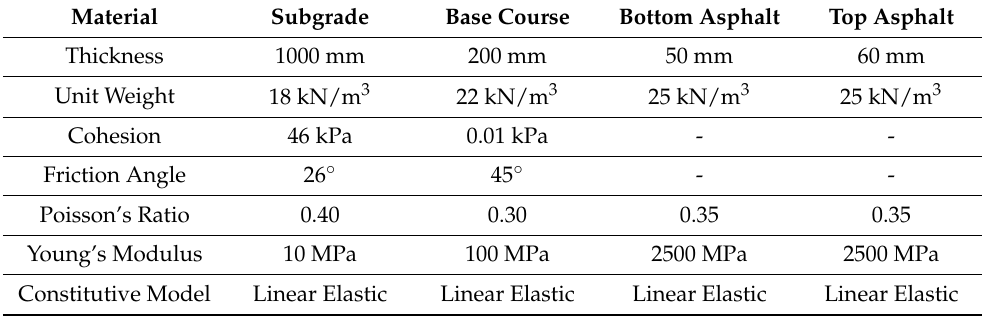
Table 1. The geometry and material properties implemented into the finite element model.